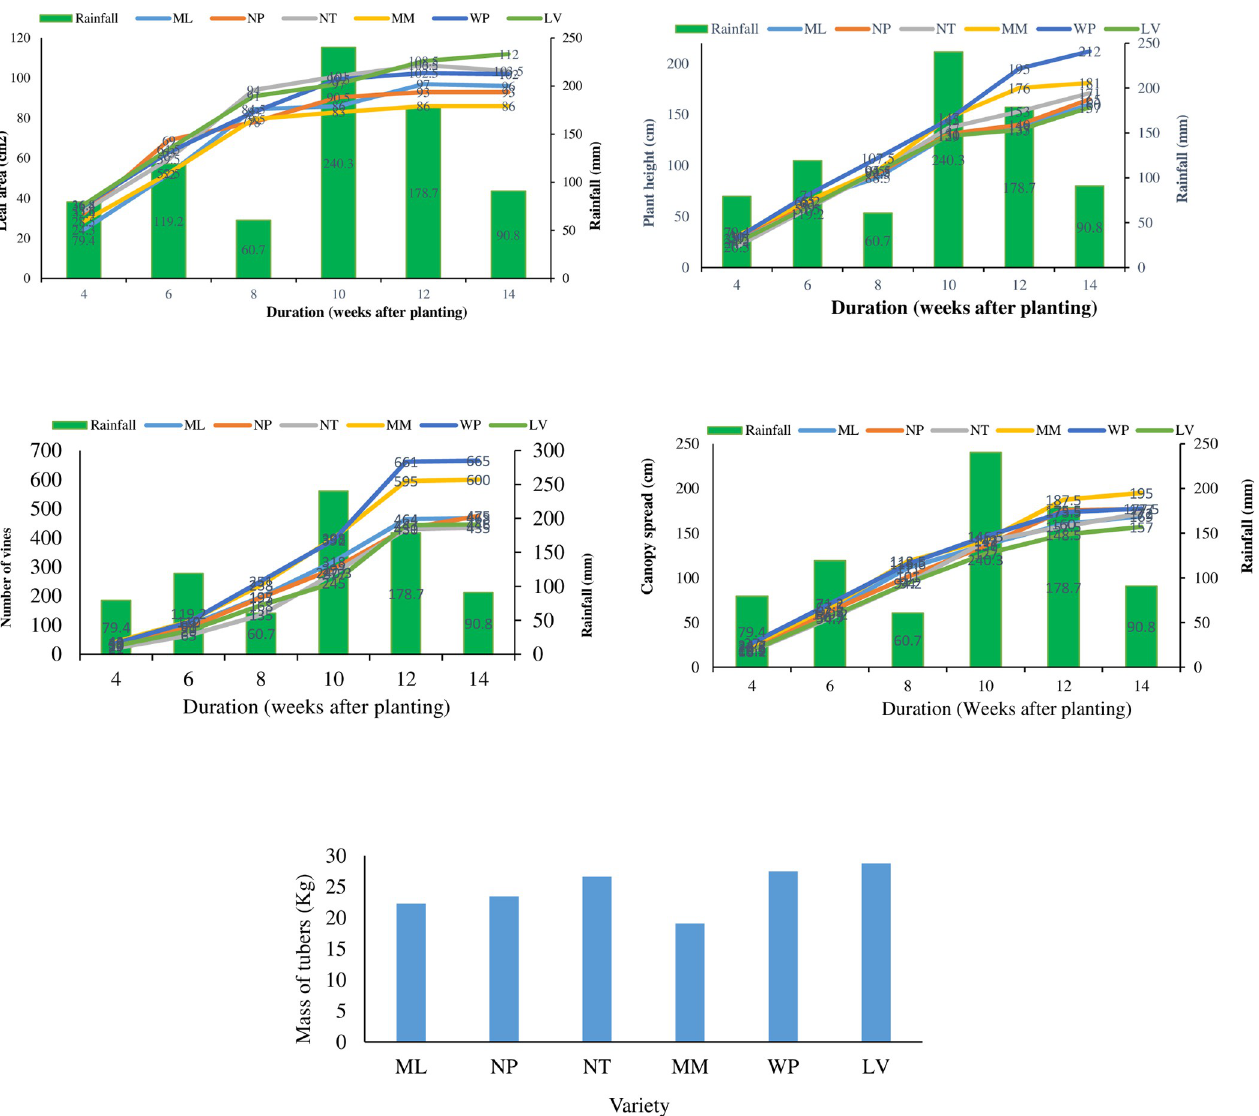
Fig 2. a: Relationship between rainfall and leaf expansion in frafra potato. b: Relationship between rainfall and plant height in frafra potato. c: Rainfall and vine production in frafra potato. d: Rainfall and plant canopy spread in frafra potato. e: Tuber mass production in frafra potato. LV = Local variety, ML = Maa-Lana, MM = Manga-Moya, NP = Nutsuga Peisa, NT = Nachim–Tiir, WP = WAAP